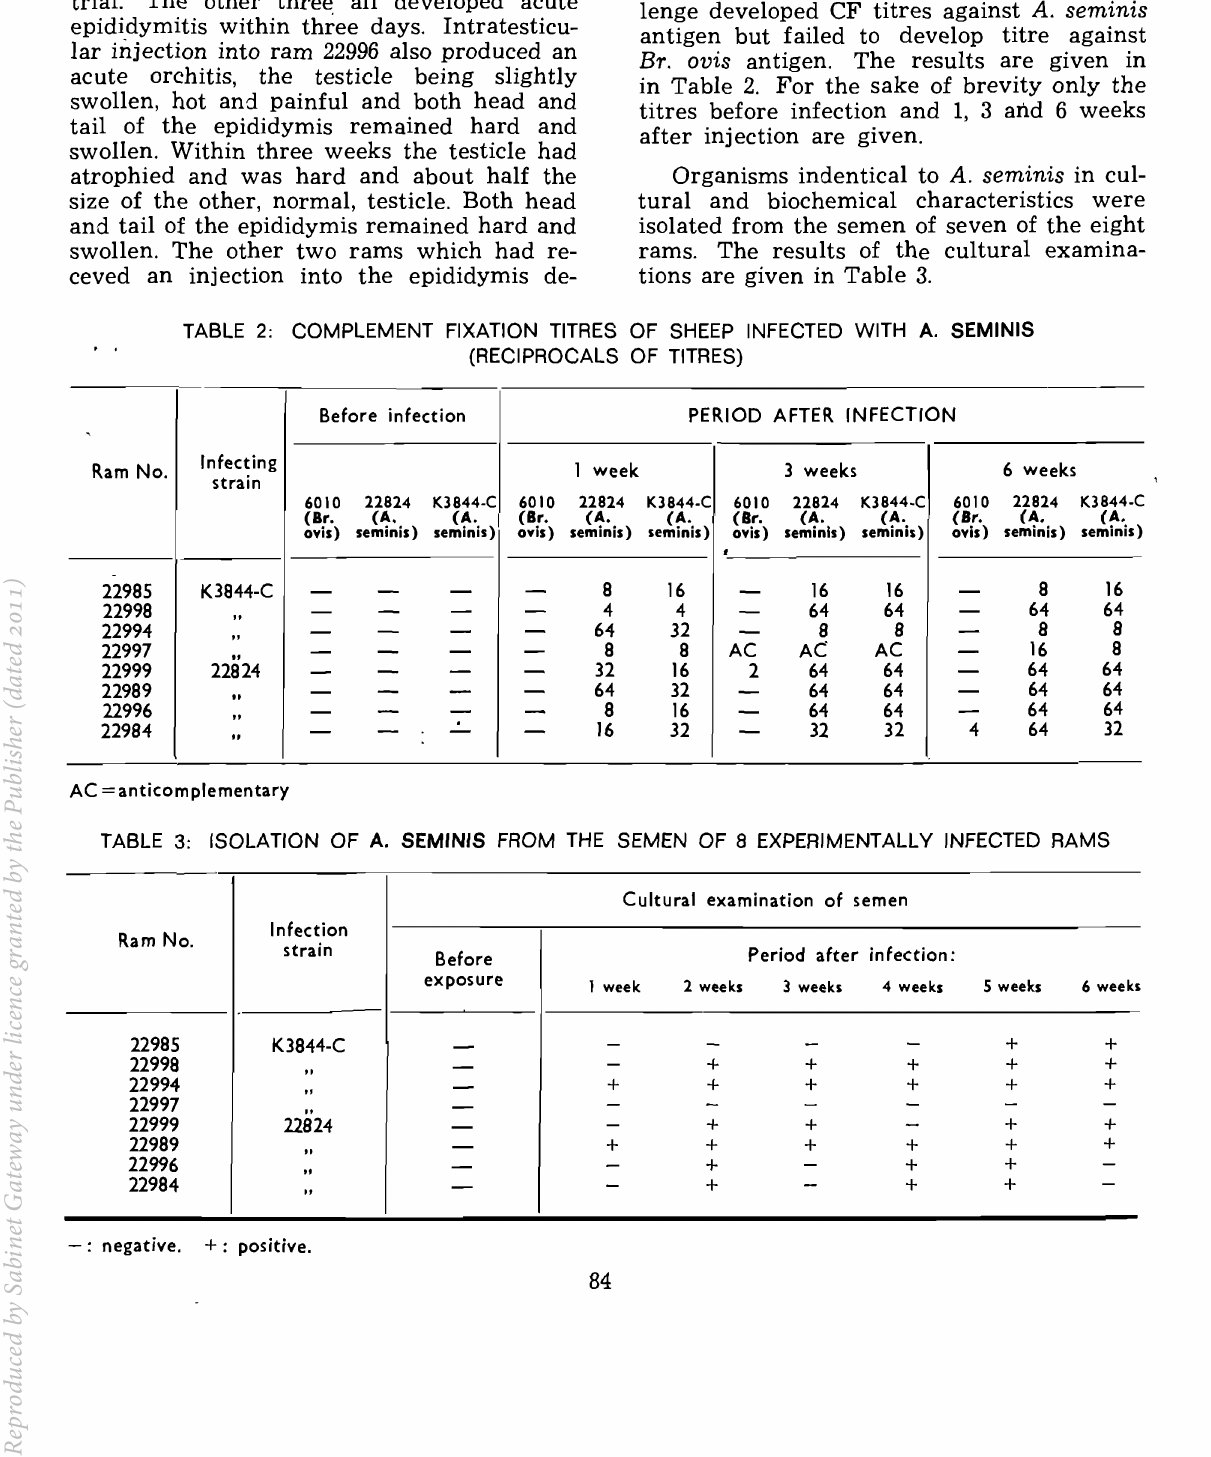
Cultural examination of semen